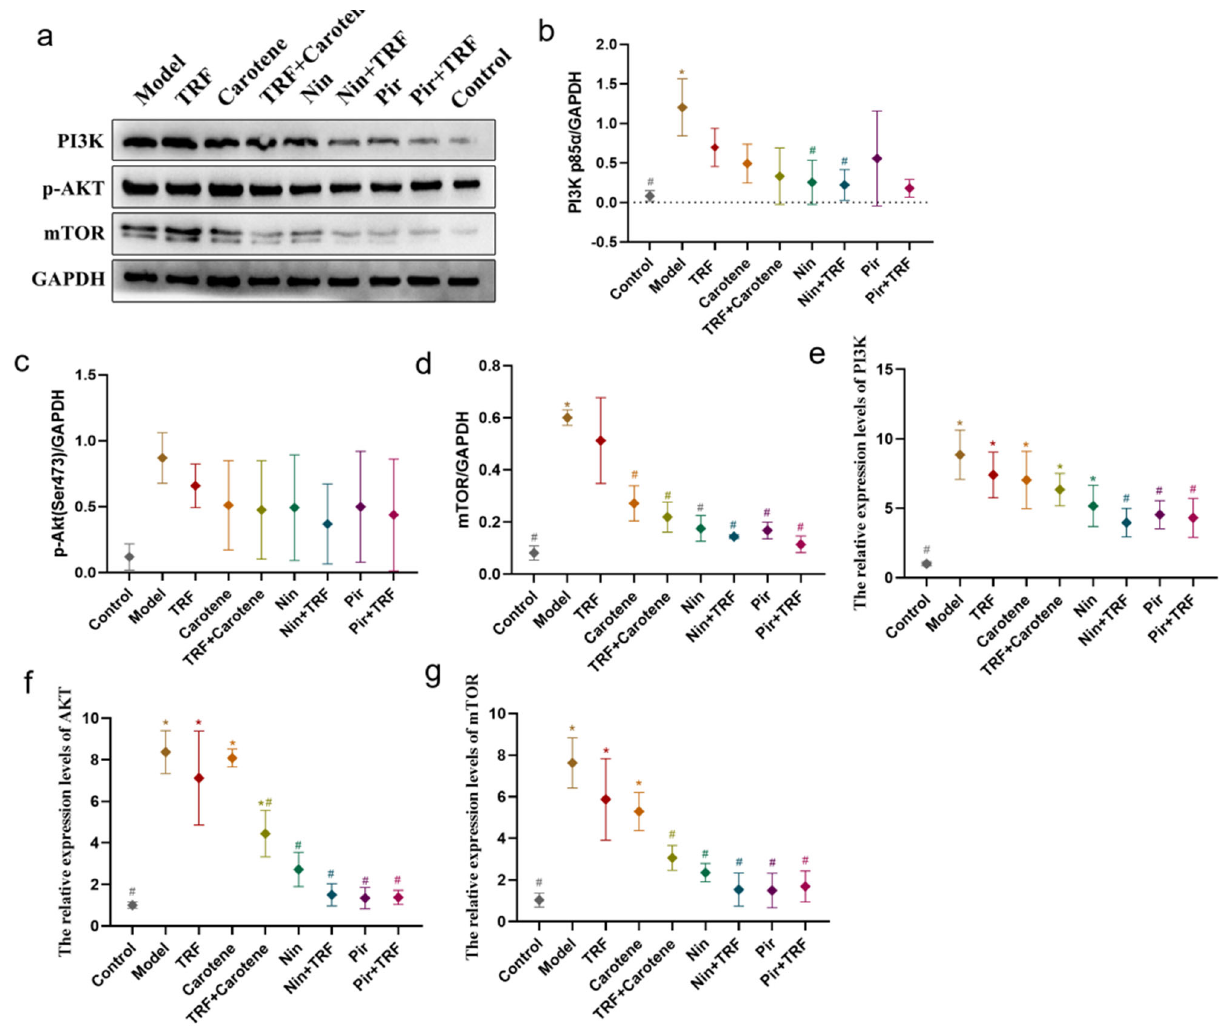
Figure 10. Inhibition of PI3K/AKT/mTOR signaling pathway provides protection against PF: ( a – d ) The expression of fibrosis proteins induced by BLM in SD rats was decreased; the protein expressions of PI3K ( b ), p ‐ AKT ( c ) and mTOR ( d ) in lung samples were examined by WB analysis; n = 3. ( e – g ) Representative statistical analysis of PI3K ( e ), AKT ( f ) and mTOR ( g ) mRNA by RT ‐ qPCR; n = 3. Note: * represents p < 0.05 in comparison to the control group; # represents p < 0.05 in comparison to the model group.